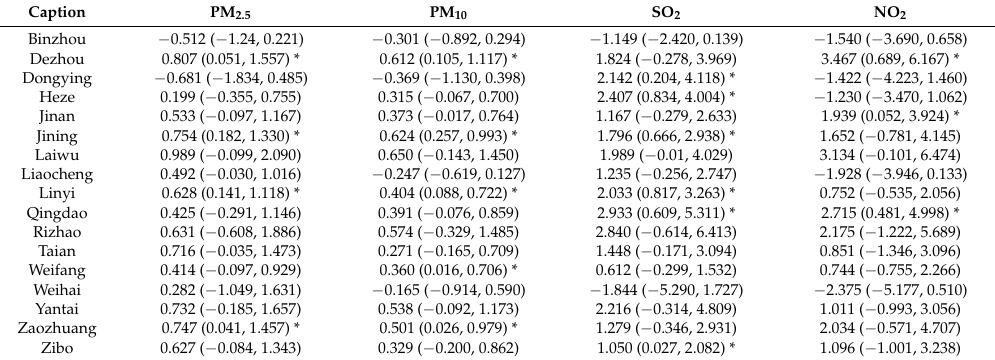
Table A8. Percentage changes of the relative risk of male COPD hospitalizations and their 95% confidence interval (CI) per 10- µ g/m 3 increase in air pollutants in the 17 cities of the Shandong province, where * indicates statistically significant estimates ( p < 0.05).